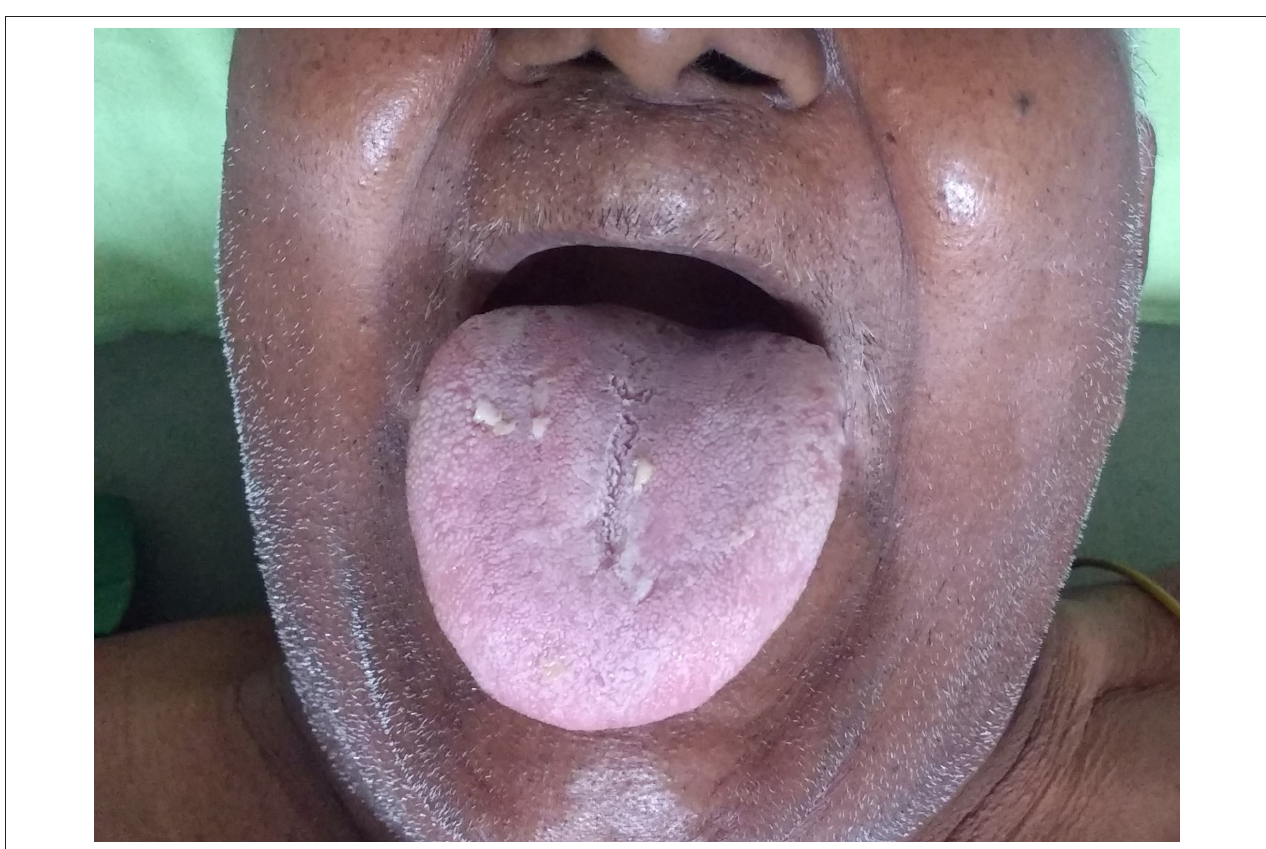
FIGURE 2 | Overnight resolution of tongue